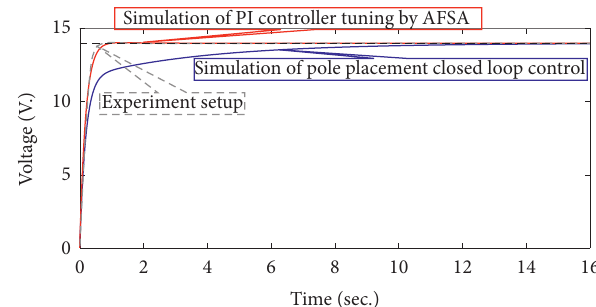
Figure 15: Comparison of the experimental and simulation results of the output